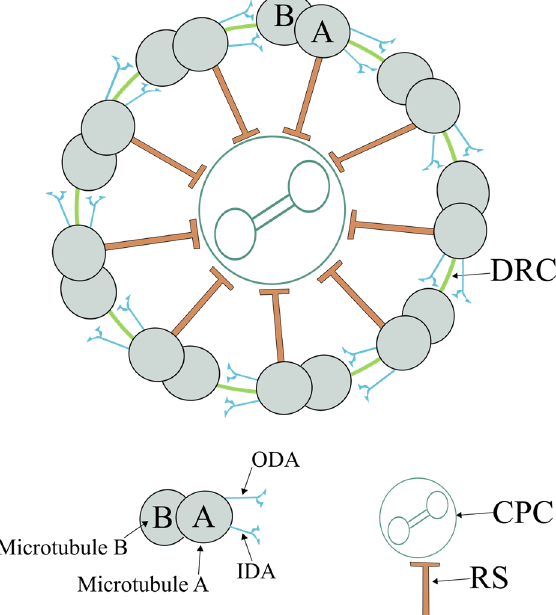
Figure 3. Schematic view of an axoneme (Ax). The Ax is composed of nine axonemal doublet microtubules (also known as the peripheral doublets) linked by the dynein regulatory complex (DRC) and connected by radial spokes (RSs) to a single pair of central Mt, which are surrounded by a fibrillar central sheath, constituting the central pair complex (CPC). The peripheral doublets are composed of microtubule A and microtubule B. From each microtubule A arise two dynein arms: the outer (ODA) and inner (IDA) dynein arms.